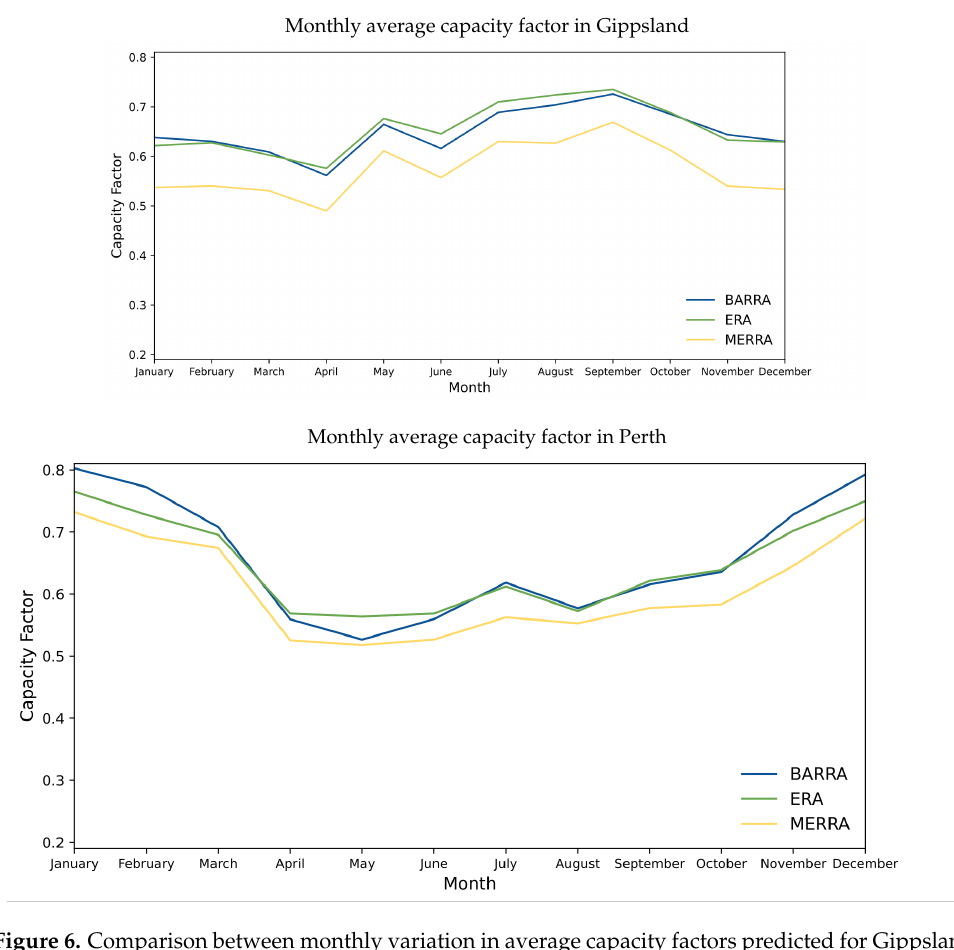
Figure 6. Comparison between monthly variation in average capacity factors predicted for Gippsland and Perth using each